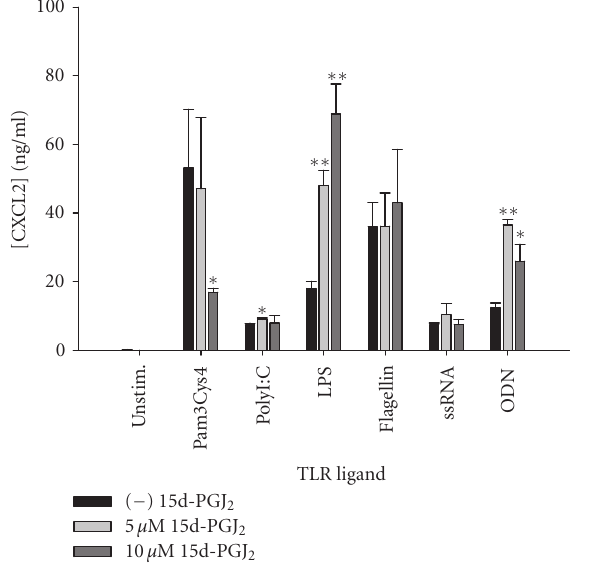
Figure 6: 15d-PGJ 2 demonstrates di ff erential e ff ects on CXCL2 production by microglia, which are TLR ligand-dependent. Primary microglia were plated at 2 × 10 5 cells/well in 96-well plates and incubated overnight. The following day, cells were pretreated for 1hour with the indicated concentrations of 15d-PGJ 2 prior to the addition of TLR ligands. Cell-conditioned supernatants were collected at 24 hours following TLR ligand exposure, whereupon CXCL2 levels were determined by ELISA. Significant di ff erences between microglia treated with TLR ligands alone versus TLR ligands + 15d-PGJ 2 are noted with asterisks ( ∗ P < . 05; ∗∗ P < . 001). Results presented are representative of two independent experiments.